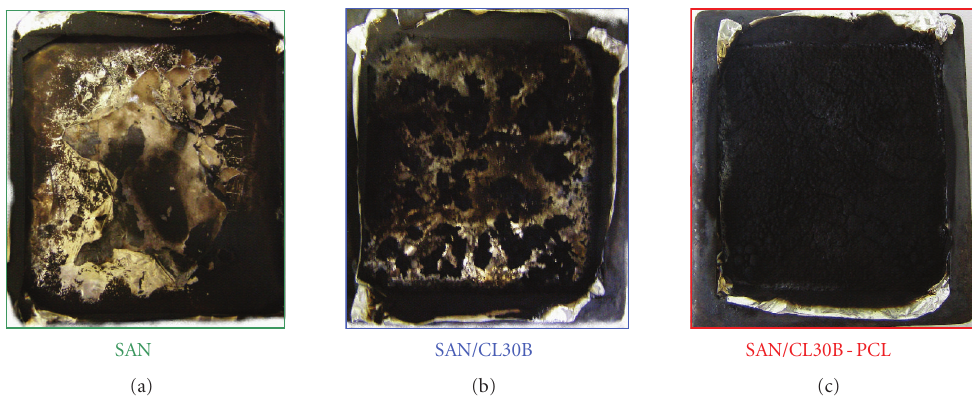
Figure 7: Photographs of the char residue recovered after cone calorimetry tests of SAN, SAN/CL30B and SAN/CL30B-PCL with 3wt% of inorganics at 35kW/m 2 heat flux.